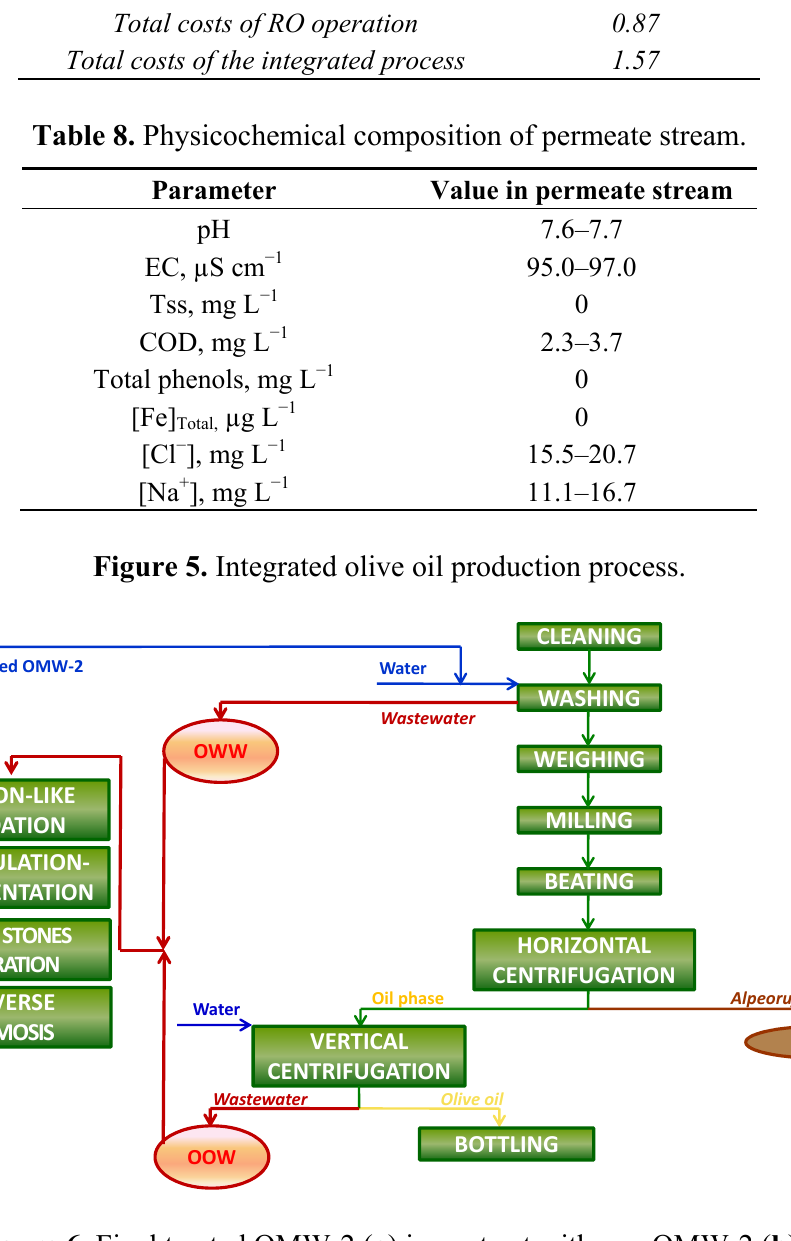
Figure 6. Final treated OMW-2 ( a ) in contrast with raw OMW-2 ( b